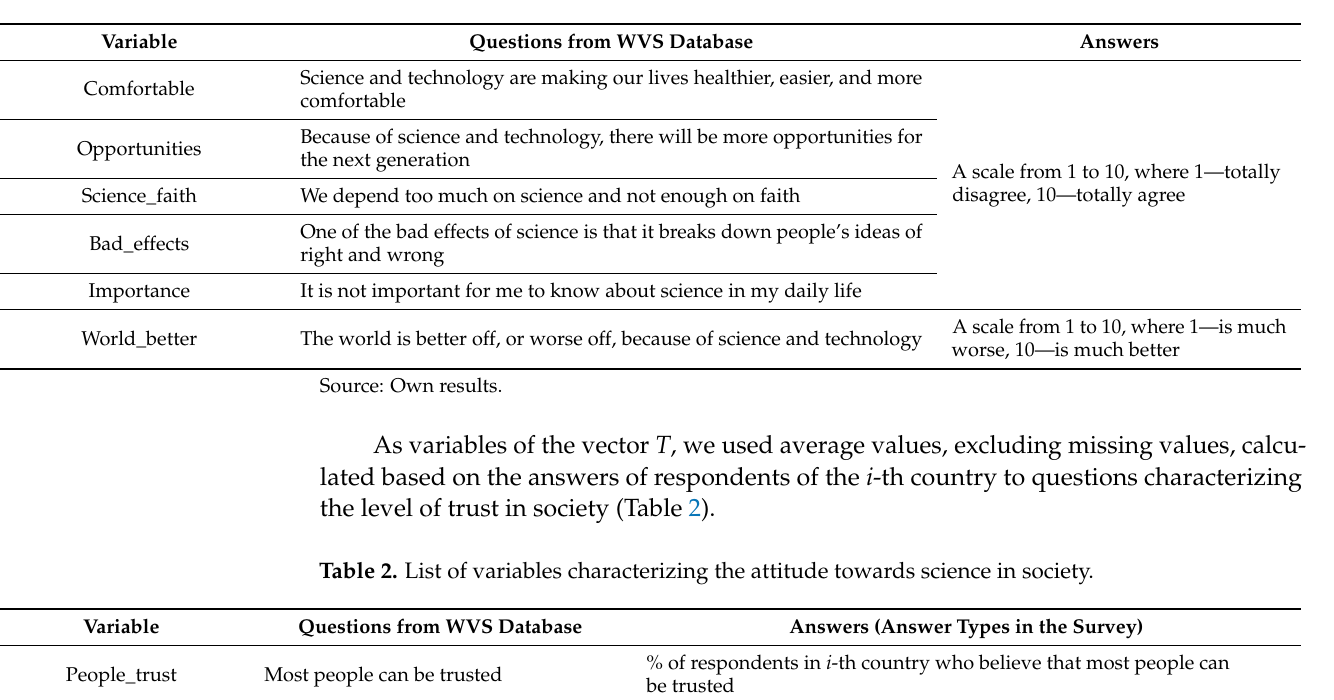
Table 1. List of variables characterizing attitudes towards science and technology in society.